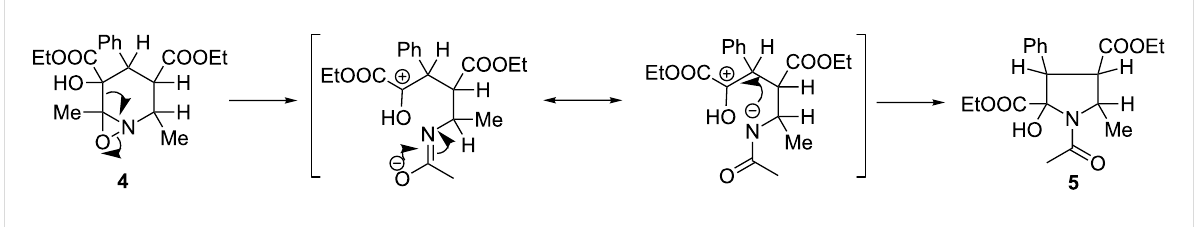
The reaction depicted in Scheme 2 proceeds as long as the hydroperoxide 2 is present in the solution, and the crude prod- uct contains the mixture of 3 , 4 and 5 . The same product mix- ture was obtained if the solution of 1 is treated with concen- trated H 2 O 2 or Fenton